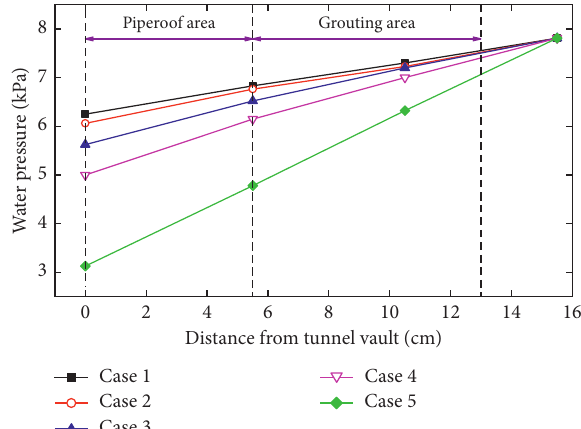
Figure 22: Variation curve of the water pressure under the tunnel invert with distance from the tunnel